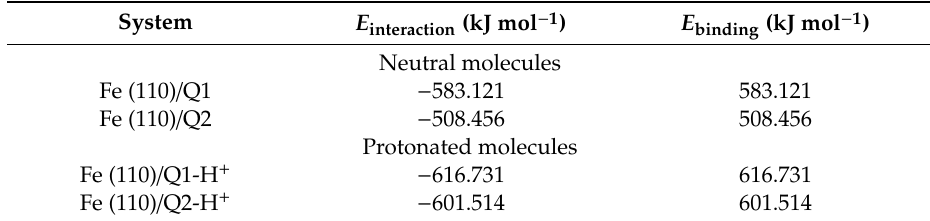
Table 6. Energy parameters estimated from MD simulations for adsorption of inhibitors in their neutral and protonated states on Fe (110) surface at 303